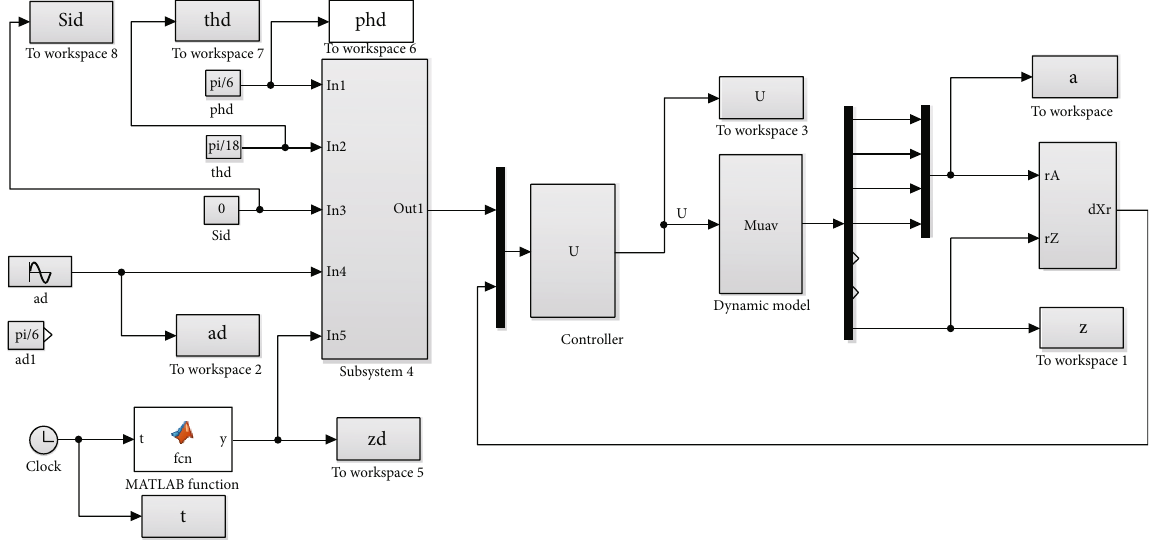
Figure 9: Simulation design of UAV with robotic